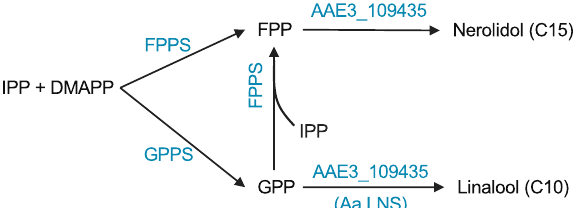
Fig. 1 The brief biosynthetic pathway of linalool and nerolidol. Linalool is a monoterpene alcohol (C10), produced from geranyl pyrophosphate (GPP). Nerolidol is a sesquiterpene alcohol (C15), produced from farnesyl pyrophosphate